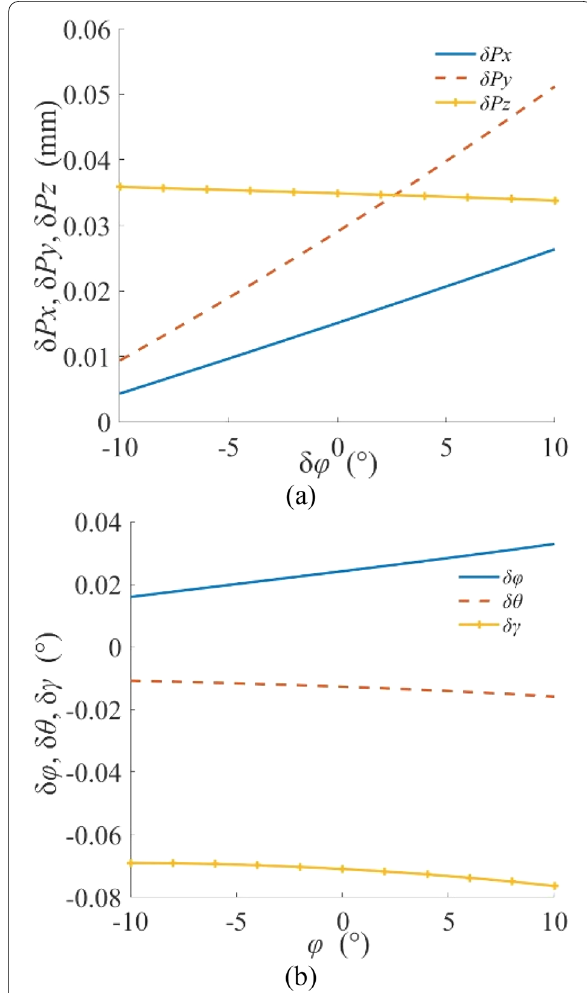
Figure 20 Relation between pose parameter φ and output